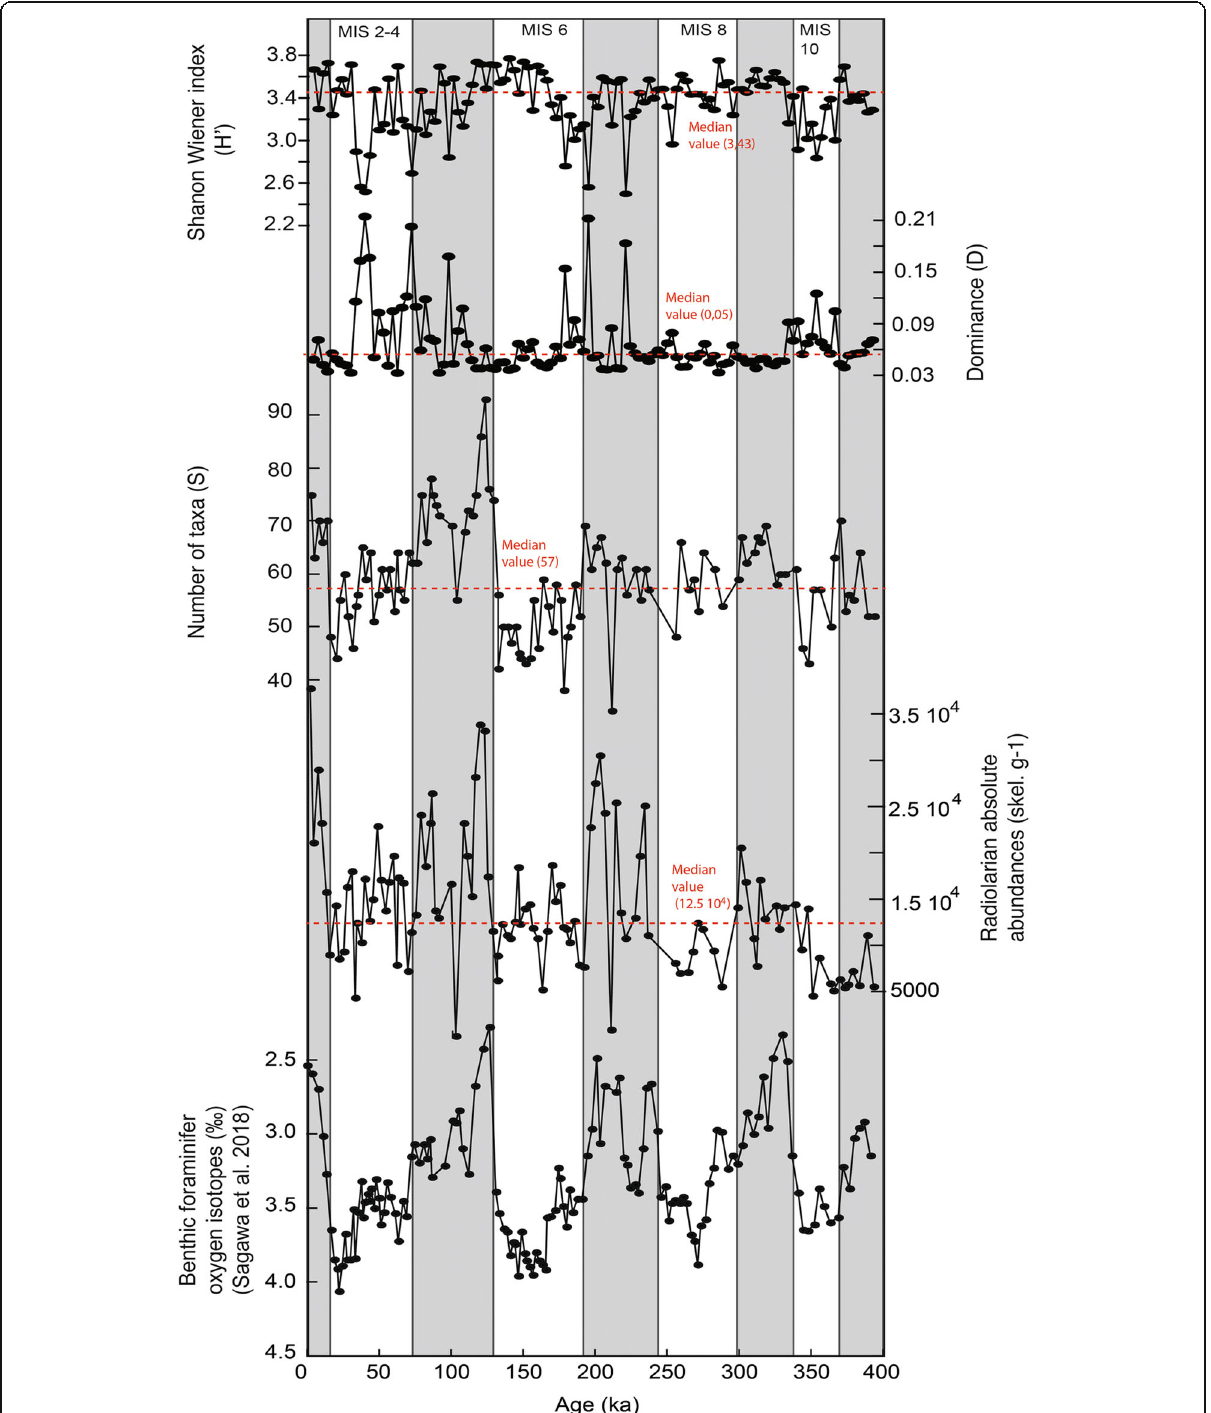
Fig. 4 Radiolarian absolute abundance. The number of taxa (S), dominance index (D), and Shannon-Wiener diversity index (H ′ ) are shown over time and compared to the benthic foraminifera isotope curve of Sagawa et al. (2018). Red lines indicate median